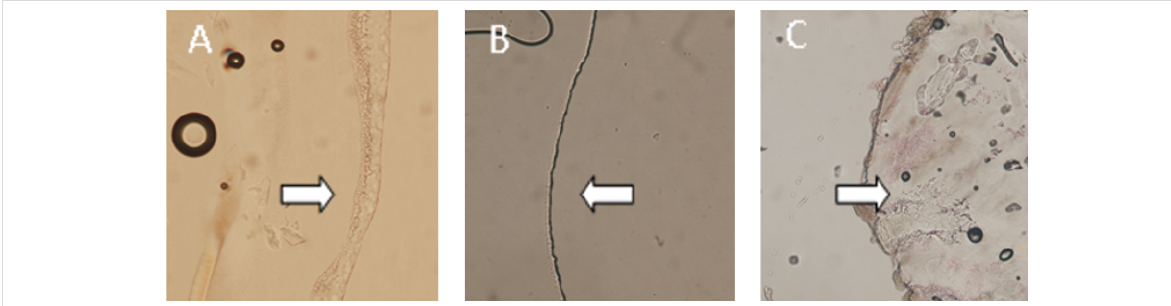
Figure 6: Cross-polarised microscopy of (A) glucose 2 × C7, 33 , (B) xylose 2 × C7, 53 , and (C) lactose 2 × C7, 70 amphiphiles under excess water conditions at 25 °C. The arrows indicate the phase at the water–amphiphile boundary.